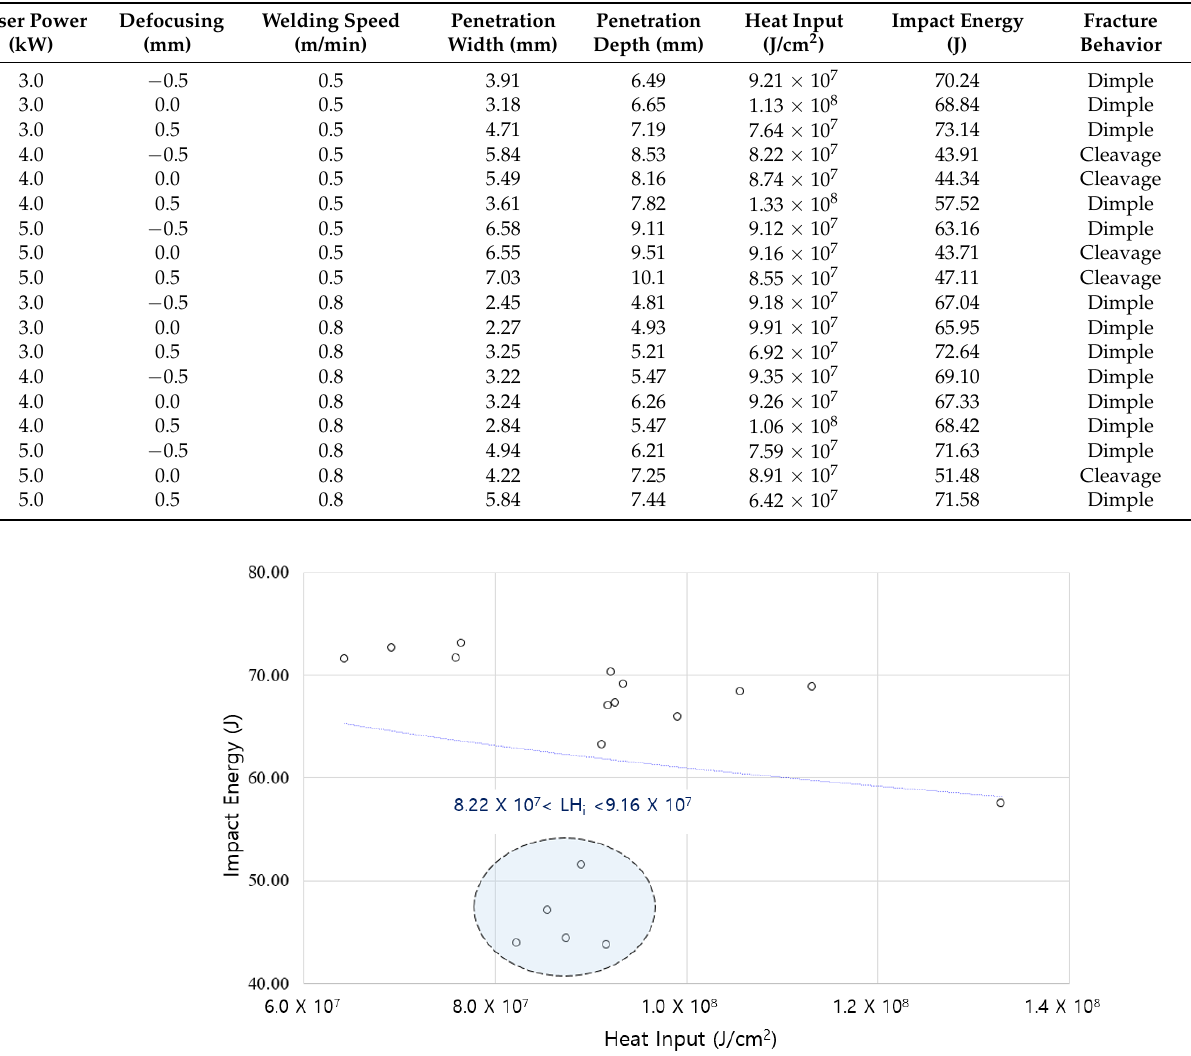
Table 8. Results of fracture behavior according to heat input in fiber laser welding.